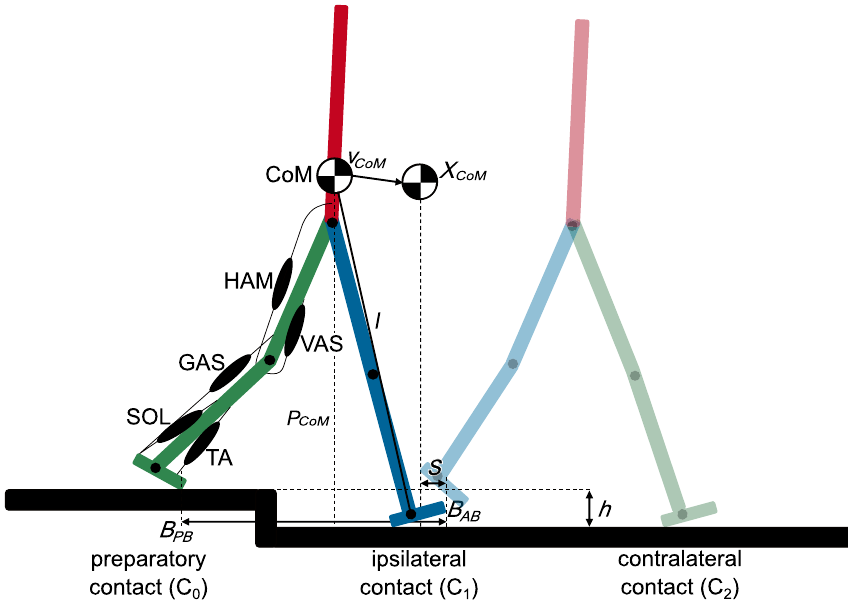
Figure 1. The model descends a drop in the ground with the perturbation height h . The contralateral leg is labelled green and the ipsilateral one blue. In the preparatory contact, the five muscles, hamstrings (HAM), vasti (VAS), gastrocnemius (GAS), soleus (SOL), and tibialis anterior (TA) are exemplarily shown in the contralateral leg.